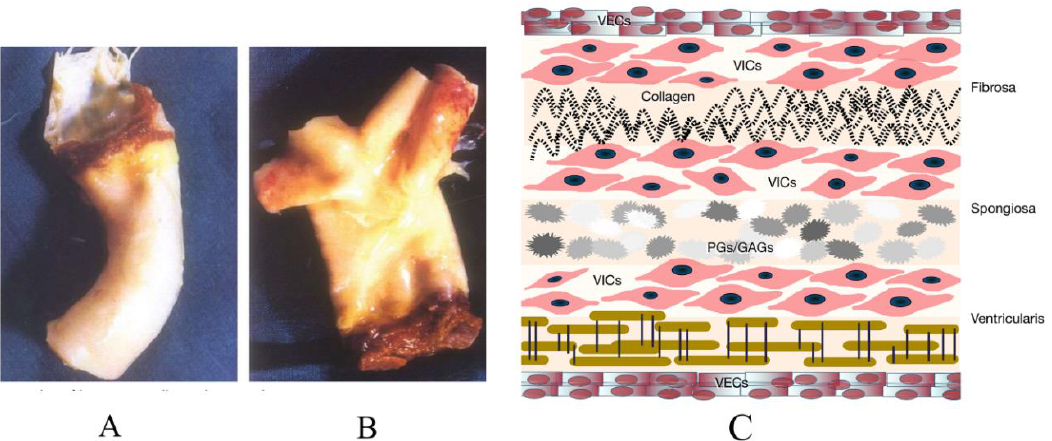
Figure 1. Photographs of human semilunar heart valves: Aortic ( A ) and pulmonary ( B ). ( C ) Detailed heart valve structure. It comprises three inner layers (ventricularis, spongiosa, and fibrosa) and an outer layer formed by valvular endothelial cells. The three inner layers contain mainly proteoglycans, glycosaminoglycans, collagen type I and type III, elastin, and valvular interstitial cells (adapted from Ref. [21]).